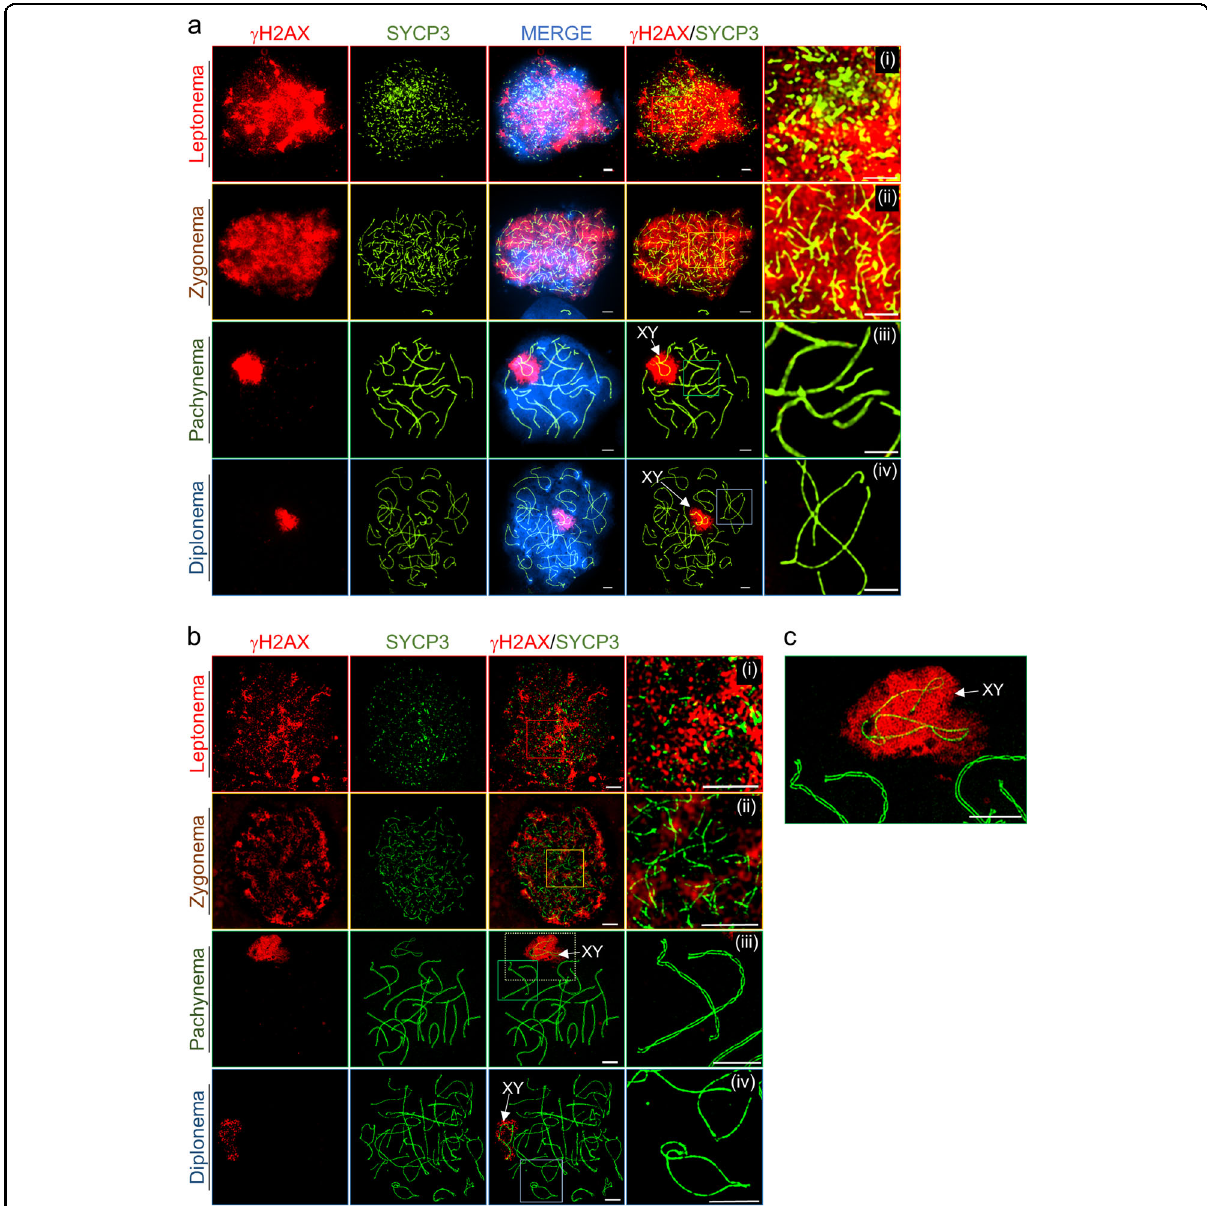
Fig. 3 DSB repair and pairing of X – Y chromosomes occur later than those of autosomal chromosomes. Imaging analysis of distribution of SYCP3 and phosphorylated H2AX ( γ H2AX) in wild-type spermatocytes during prophase I of meiosis. Nuclei were simultaneously immunostained with anti-SYCP3 (green)/anti- γ H2AX (red) and analyzed by conventional microscopy ( a ) and super-resolution microscopy ( b ) in prophase stages leptonema (i), zygonema (ii), pachynema (iii), and diplonema (iv). c Magni fi ed image corresponding to colored box of pachynema chromosomes ( b , iii). XY indicates male sex chromosomes. Bars represent 2.5 μ